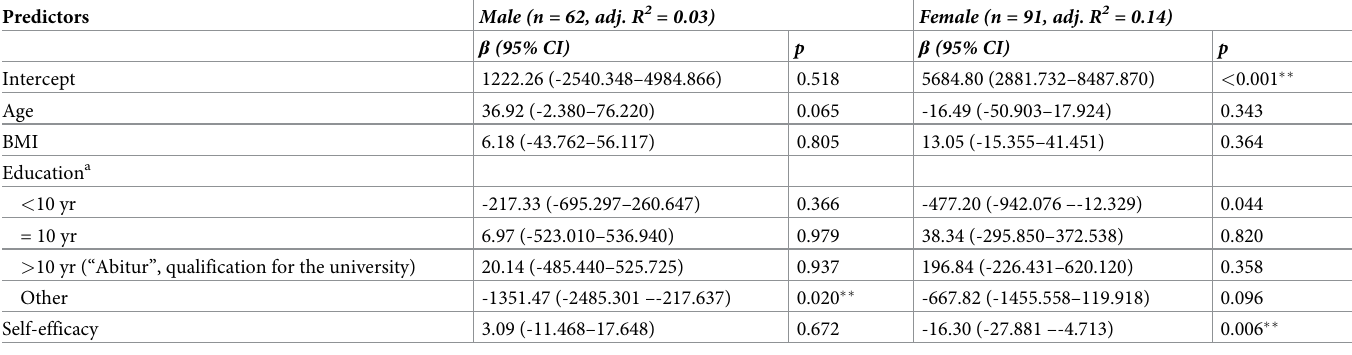
Table 7. Multiple linear regression model to identify determinants for PI, separately for men and women.